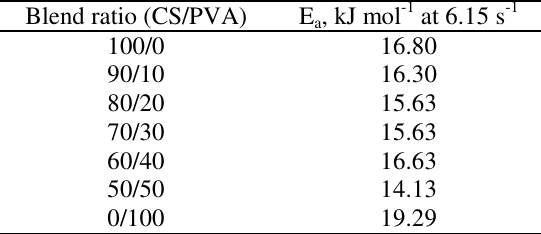
Figure 2. (a) The influence of temperature on viscosity of CS/PVA mixture solutions at a constant shear rate and (b) the Arrhenius plot of ln η versus 1/T for the same mixture solutions Table 2. Values of the activation energy of chitosan, PVA and their blends at 6.15 s -1 Blend ratio